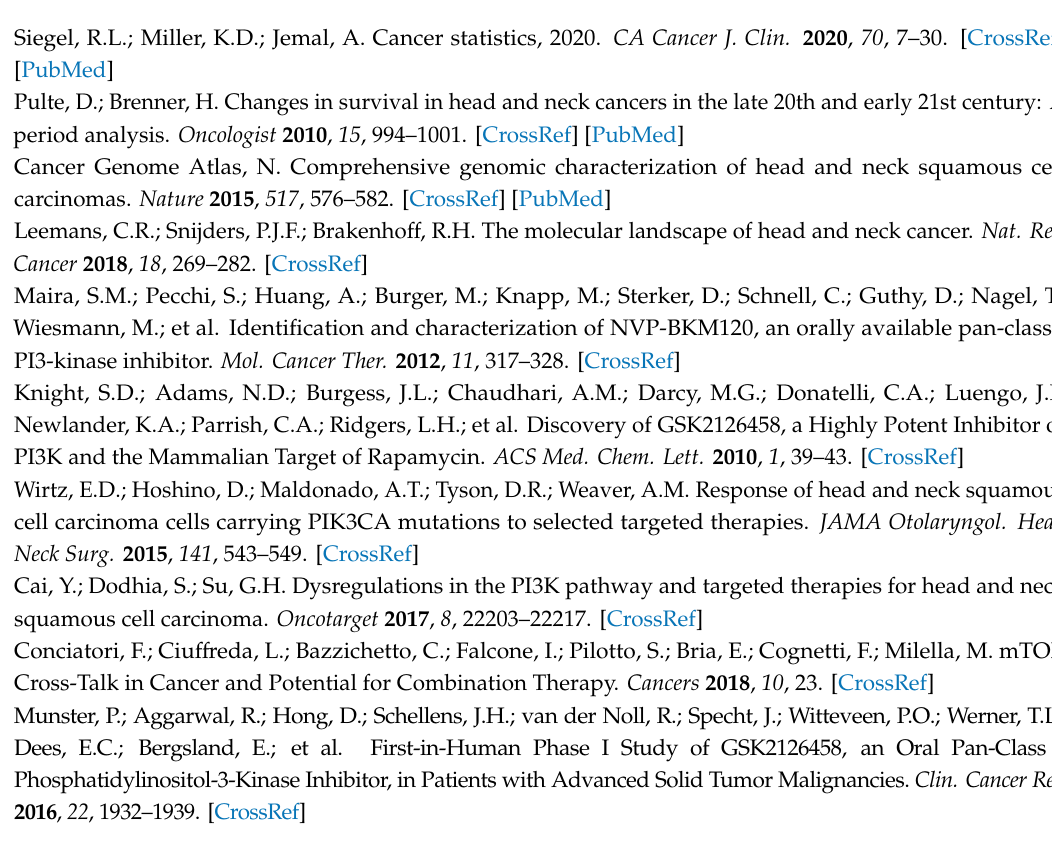
Figure S1: PI3K inhibitors and autophagy, Figure S2: Uncropped Western